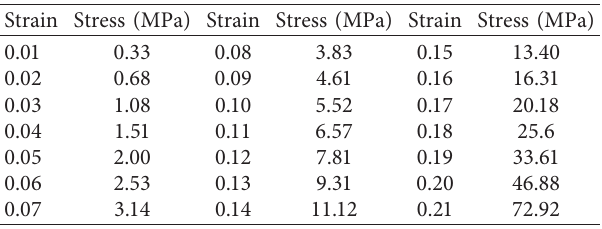
Table 2: Relationship between stress and strain for gob material in the double-yield model.